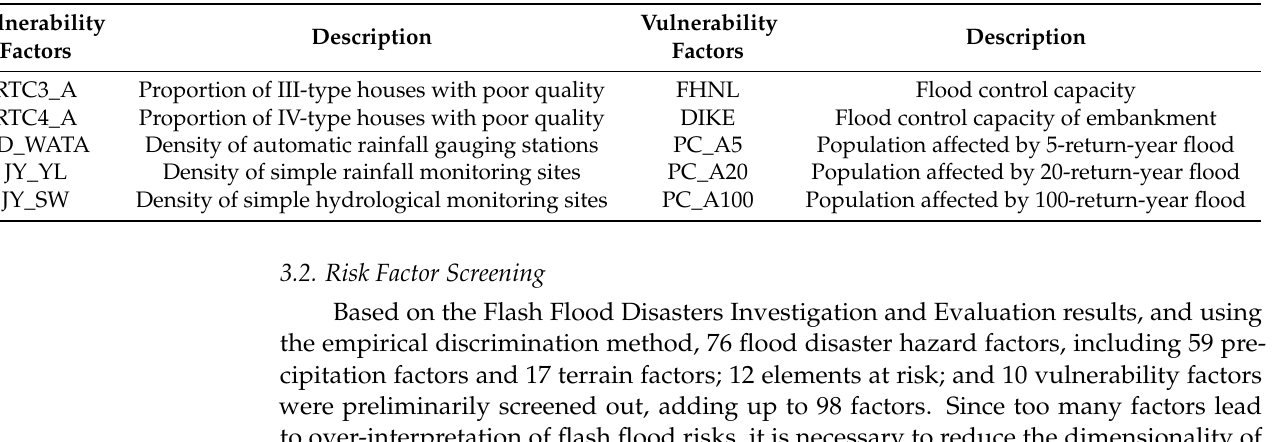
Table 4. Statistics on Flood Prevention Capacity in Small